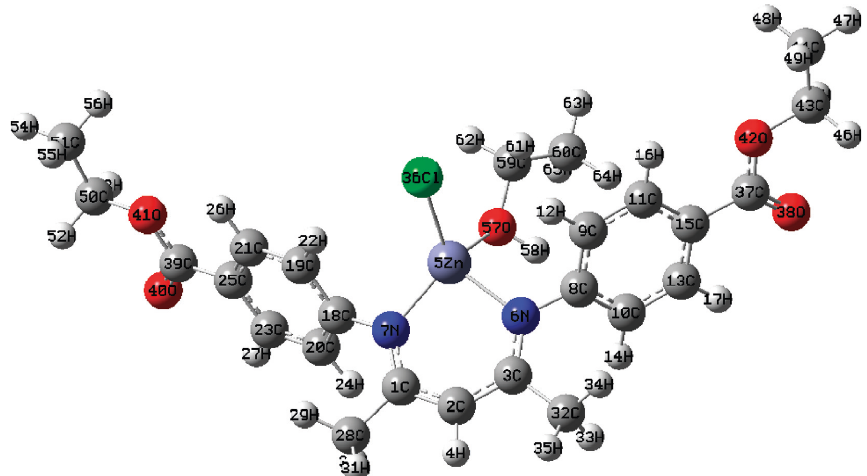
Figure 4: Structure of the model compound used to evaluate M062x/6-31G(d) for geometry optimization of the Zn(II) β -diketimine complex 3 . Table 3: Selected bond lengths and bond angles calculated at the M062x method with the 6-31G(d) basis set for 1 and its tautomer. β -Diketimine β -Diketimine